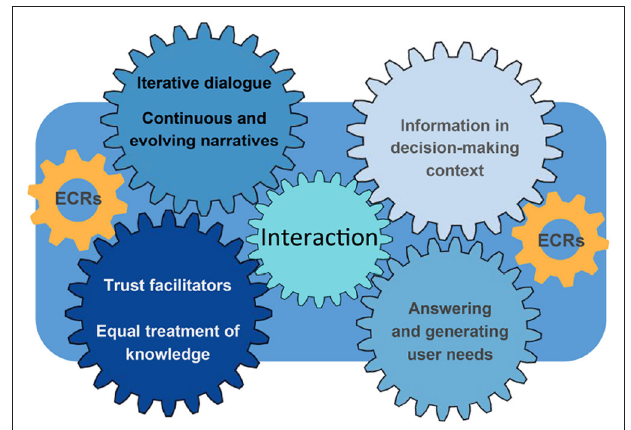
FIGURE 1 | Overview on proposed way forward to foster interactions between scientists and